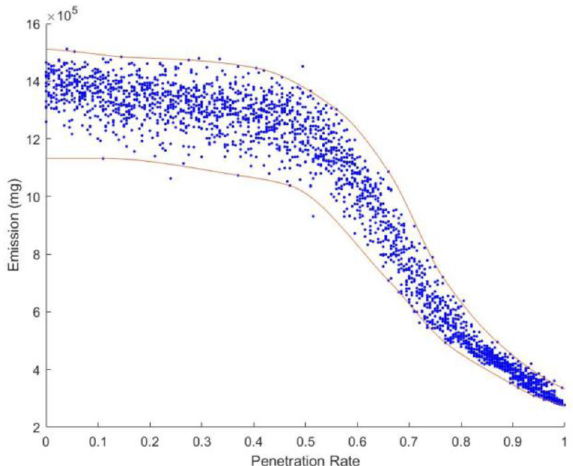
Figure 10 Massive illustration of emission over penetration